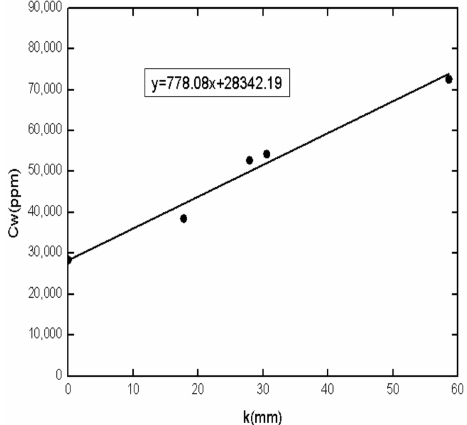
Figure 10. The relationship between k and C w ( S w = 80%).